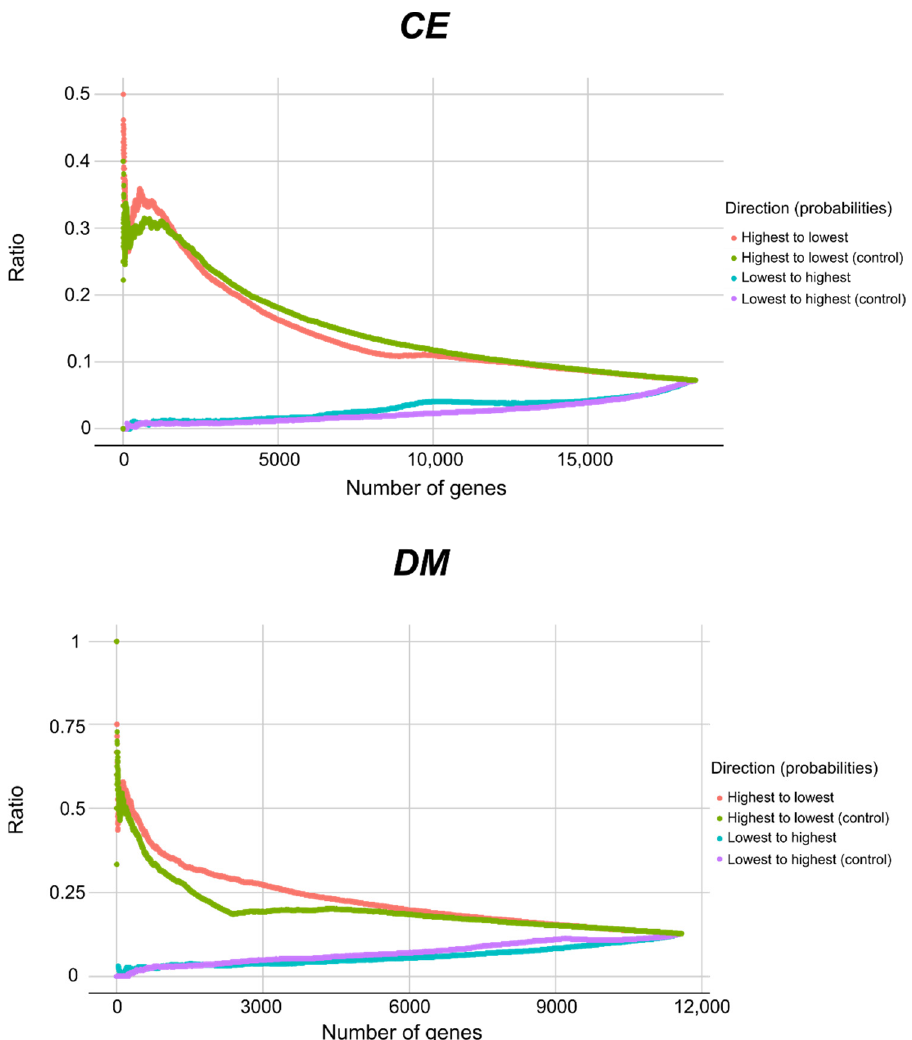
Figure 3. Validation of cross-species essential gene predictions. Following the predictions between species using extreme gradient boosting (XGB) models trained with select features identified in the within-species approach, genes were ranked by the essentiality probabilities. The ranked genes ( x -axis) were cumulatively searched from the highest to the lowest probabilities, as well as from the lowest to the highest against the GExplore database [25] ( DM data used to predict CE — top ) and GenomeRNAi database [26] ( CE data used to predict DM — bottom ). Cumulative ratios of genes with a ‘lethal’ phenotype reported in each database were calculated ( y -axis). Ranked genes following training and prediction within species were used as controls.